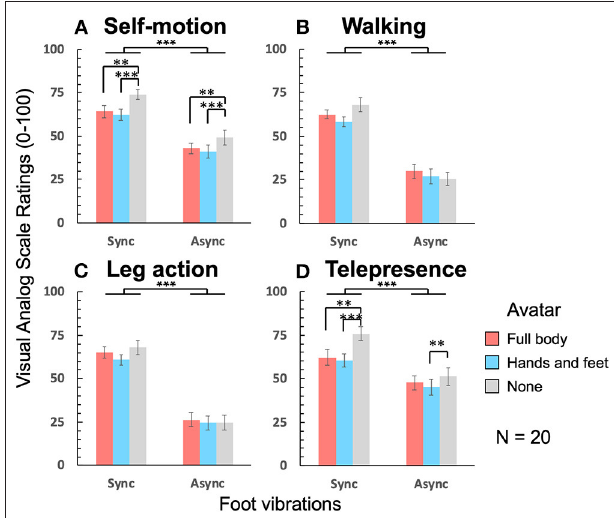
FIGURE 7 | Results of experiment 2. (A) Self-motion, (B) walking sensation, (C) leg action sensation, and (D) telepresence. Bar plots indicate means ± SEM. * p < 0.05; ** p < 0.01; *** p <